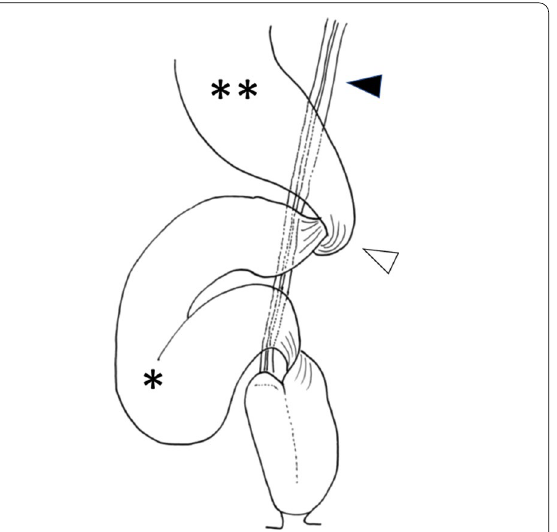
Fig. 6 Schematic of the operative findings and procedures showing the volvulus on its long axis. *: Ileal volvulus, **: dilated proximal ileum, black up-pointing triangle: superior mesenteric artery and vein, white up-pointing triangle: adhesion to the presacrum